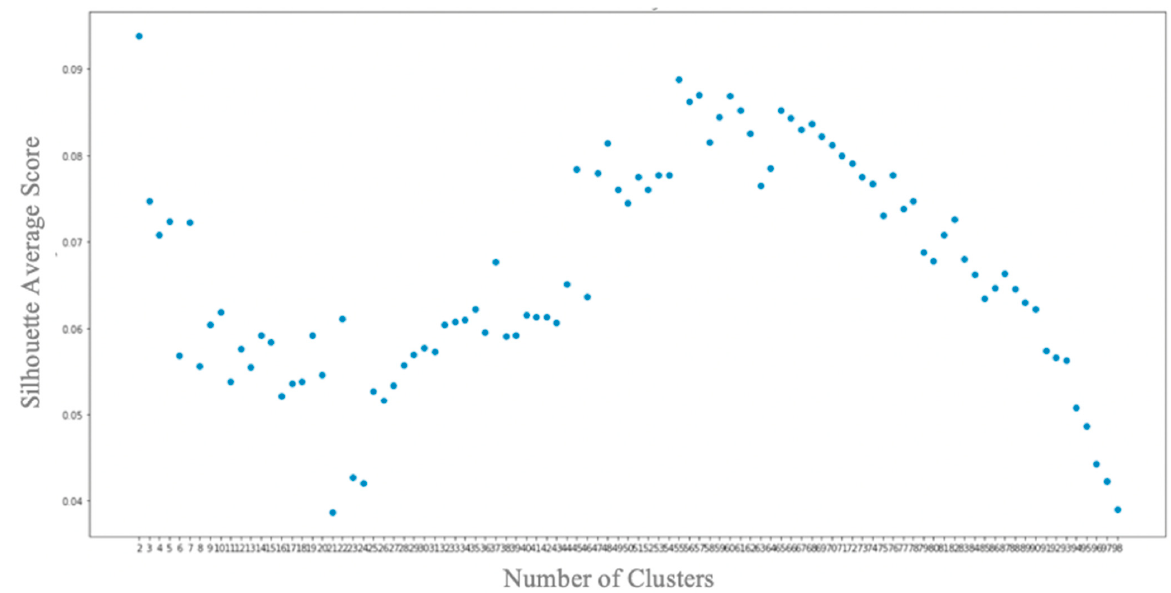
Figure 12. Silhouette average score.